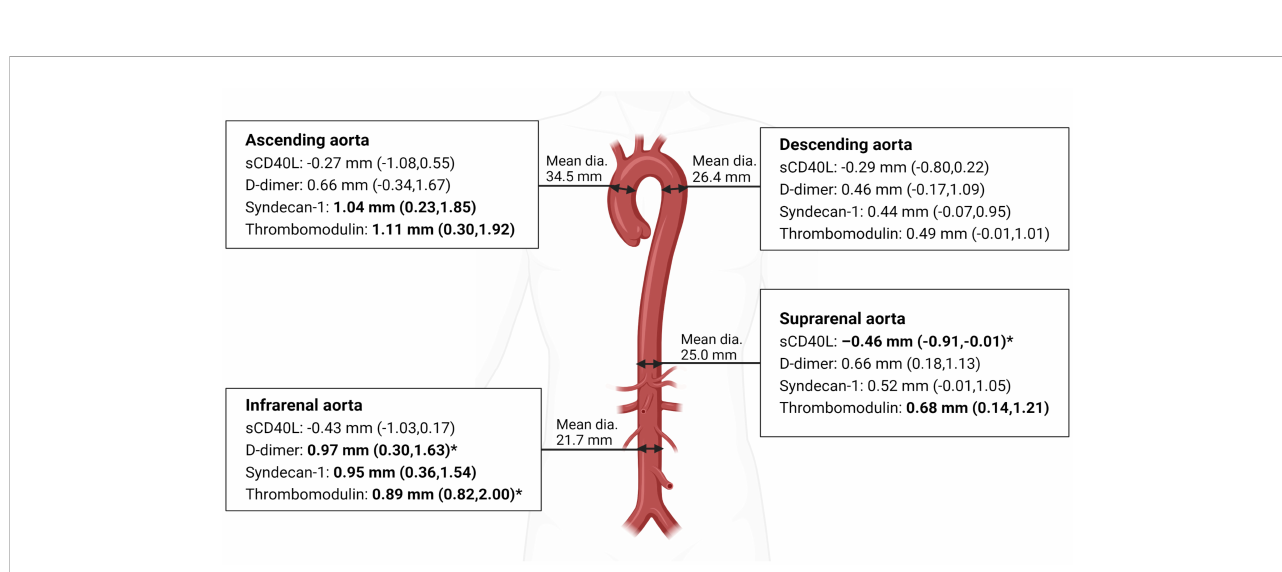
FIGURE 2 Aortic diameter measured as maximum outer diameter. Mean diameter and larger or smaller diameter in mm (95% CI) associated with high level of the biomarker. Bold text: signi fi cant associations. *Adjusted for age, sex, hypertension, smoking status, and BMI category. (Made with